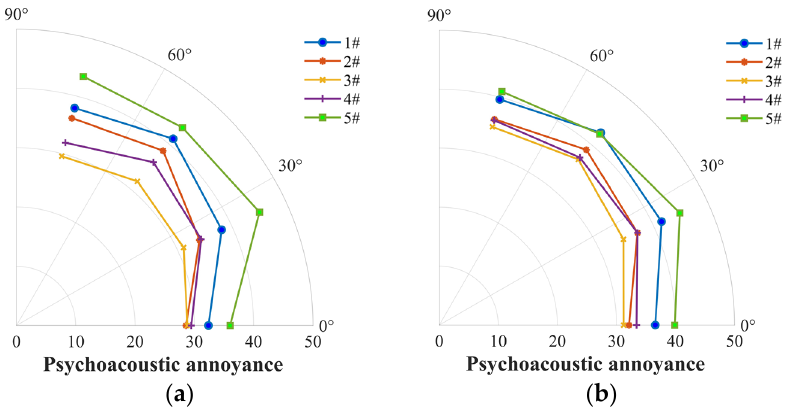
Figure 18. Comparison of psychoacoustic annoyance (Di’s model) among the two-blade propeller (#1), four-blade propeller (#2), loop-type propeller (#3), wide chord loop-type propeller (#4), and DJI Phantom III propeller (#5) at a rotational speed of 5400 rpm ( a ) and at a stable thrust of 3 N ( b ).